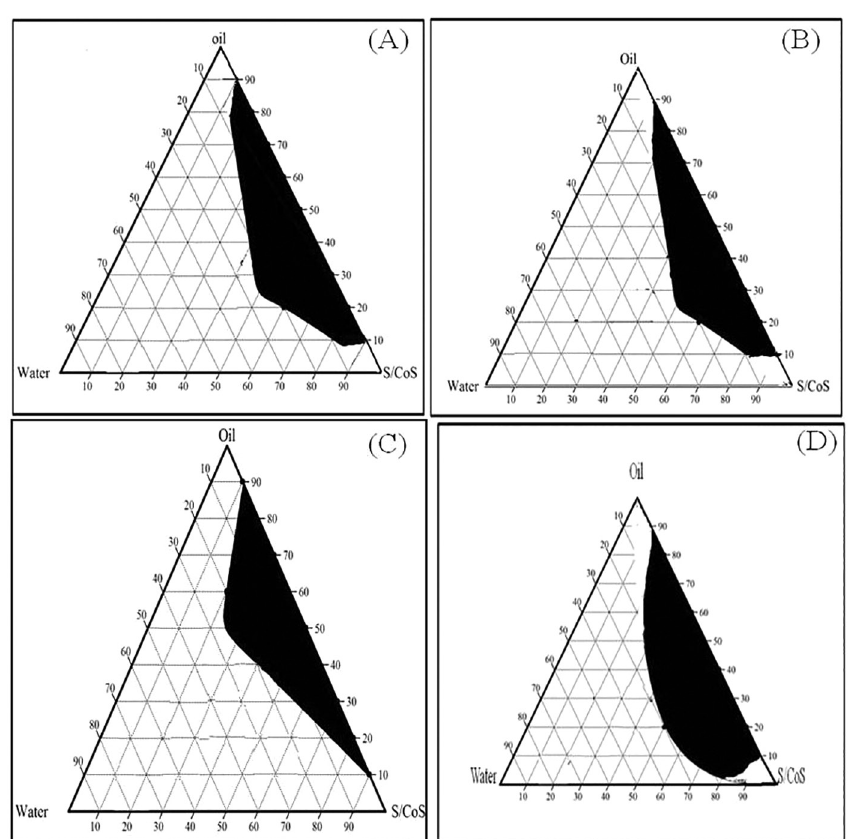
FIGURE 3 - Ternary phase diagrams of different selected systems dispersed in water at 25 °C. (Oil = lauroglycol FCC, Surfactant = Chremophor EL, Co-surfactant = Transcutol P) Ratio of surfactant to cosurfactant in (a) is 0.5:1, (b) is 1:1, (c) is 1.5:1 and (d) is 2:1. Dark area shows oil in water microemulsion TABLE IV - Globule size and polydispersity index of FL SMEDDS at different pH conditions